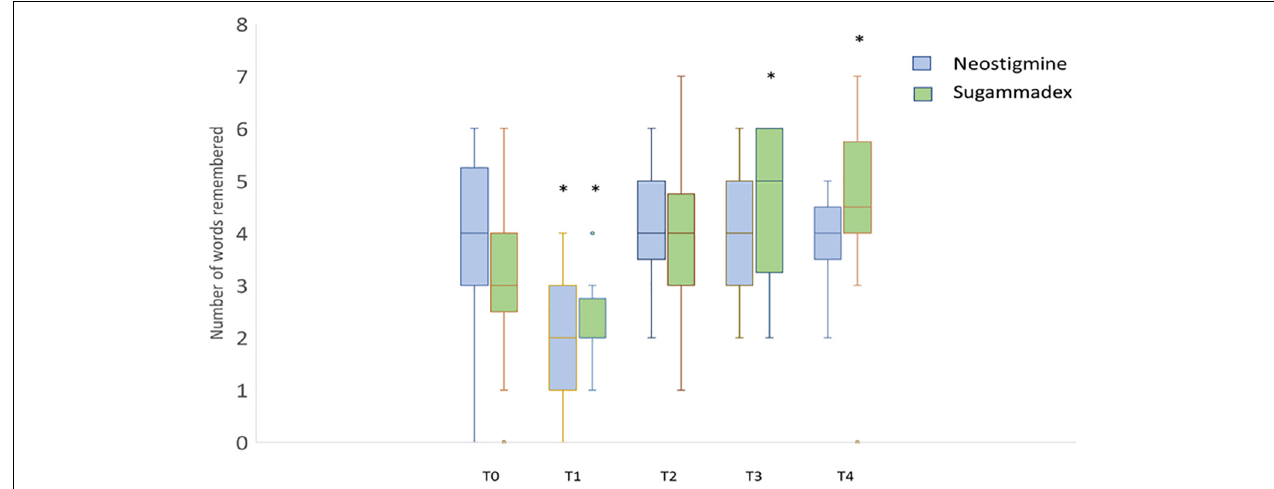
FIGURE 3 | Cognitive domain: word list category. Boxplot diagram showing the effects on cognitive level by asking a patient to repeat as many words as he/she could remember from a list, at different times before surgery (T0) and 30 min (T1), 24 h (T2), 72 h (T3), and 30 days (T4) after surgery. Statistically significant differences (* p < 0.05) were detected at 30 min both for neostigmine ( p = 0.017) and sugammadex ( p = 0.008), and 72 h ( p = 0.037) and 30 days ( p = 0.043) after surgery in patients receiving sugammadex when compared to data obtained prior to surgery (T0). Neostigmine-treated patients (blue) and sugammadex-treated patients (green).